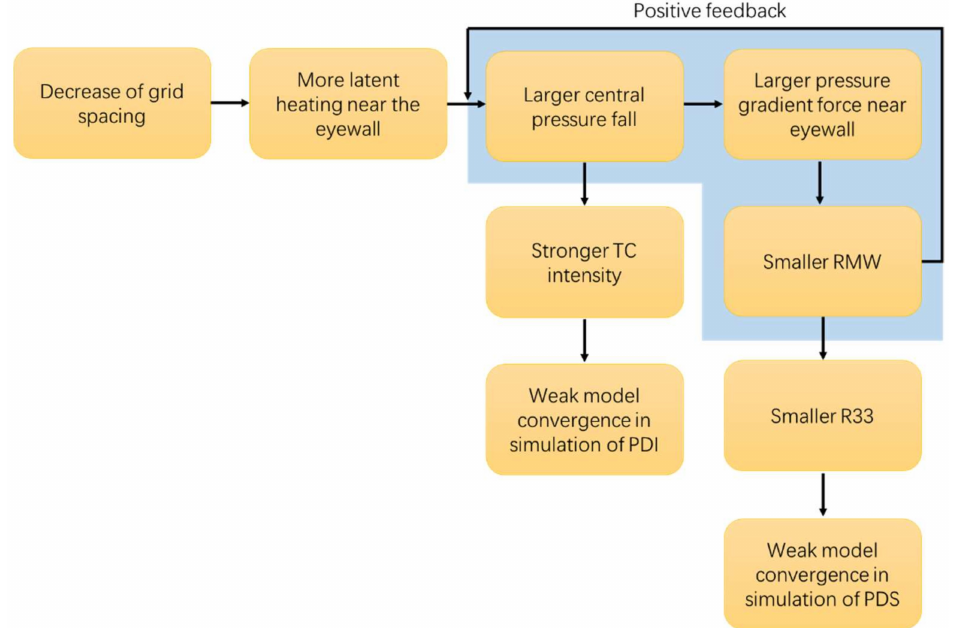
Figure 9. Schematic diagram summarizing the possible reasons for the dependence of model convergence in simulations of the TC PDI and PDS. Blue shading indicates the positive feedback of smaller RMW on central pressure fall.